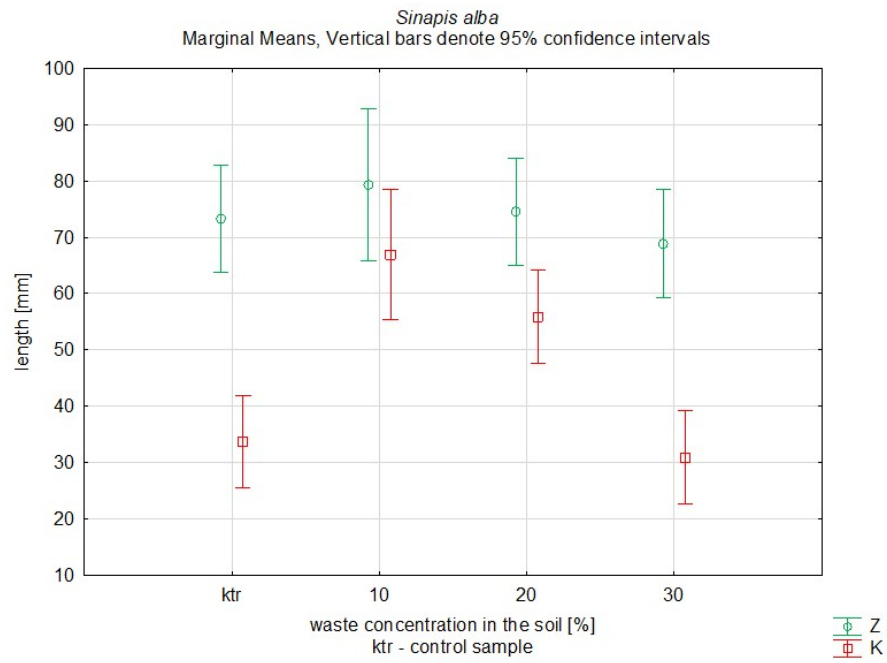
Figure 7. The growth of roots (K) and shoots (Z) of Sinapis alba on the medium with various additions of waste.